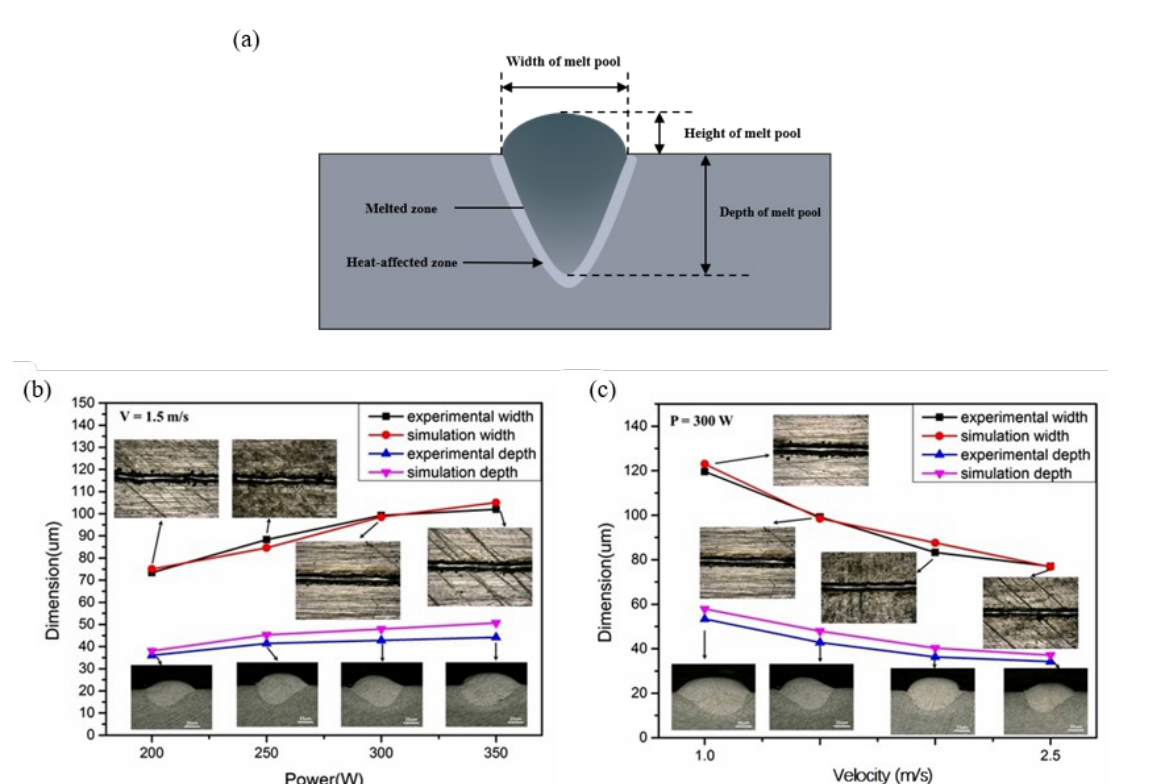
Figure 8. Schematic diagram of melt pool and its dimension ( a ); morphology and shape of the melt pool in experiment and simulation with different laser power ( b ); scanning velocity ( c